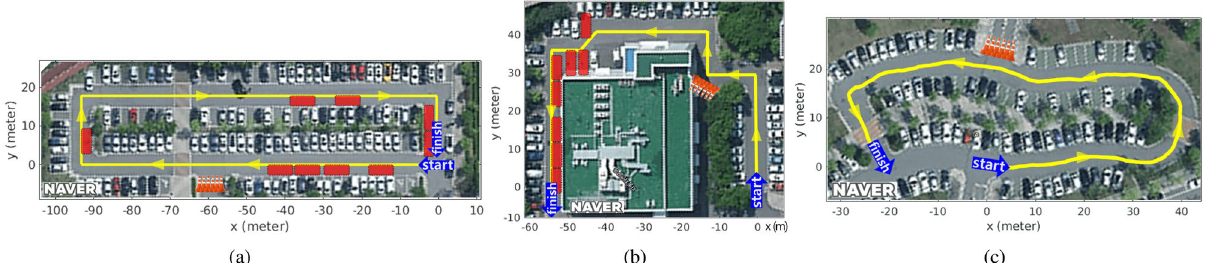
Figure 8. Parking lots used in the real autonomous driving experiment. At intersections, traffic cones are used to guide vehicles to drive in one direction. The yellow line is the center of the drivable area. The red boxes represent obstacle vehicles that were present in the fifth experiment. ( a ) Yellow line is about 230 m long; this parking lot was used to collect the training dataset for imitation learning. ( b ) Yellow line is 139 m long. ( c ) Yellow line is 149 m